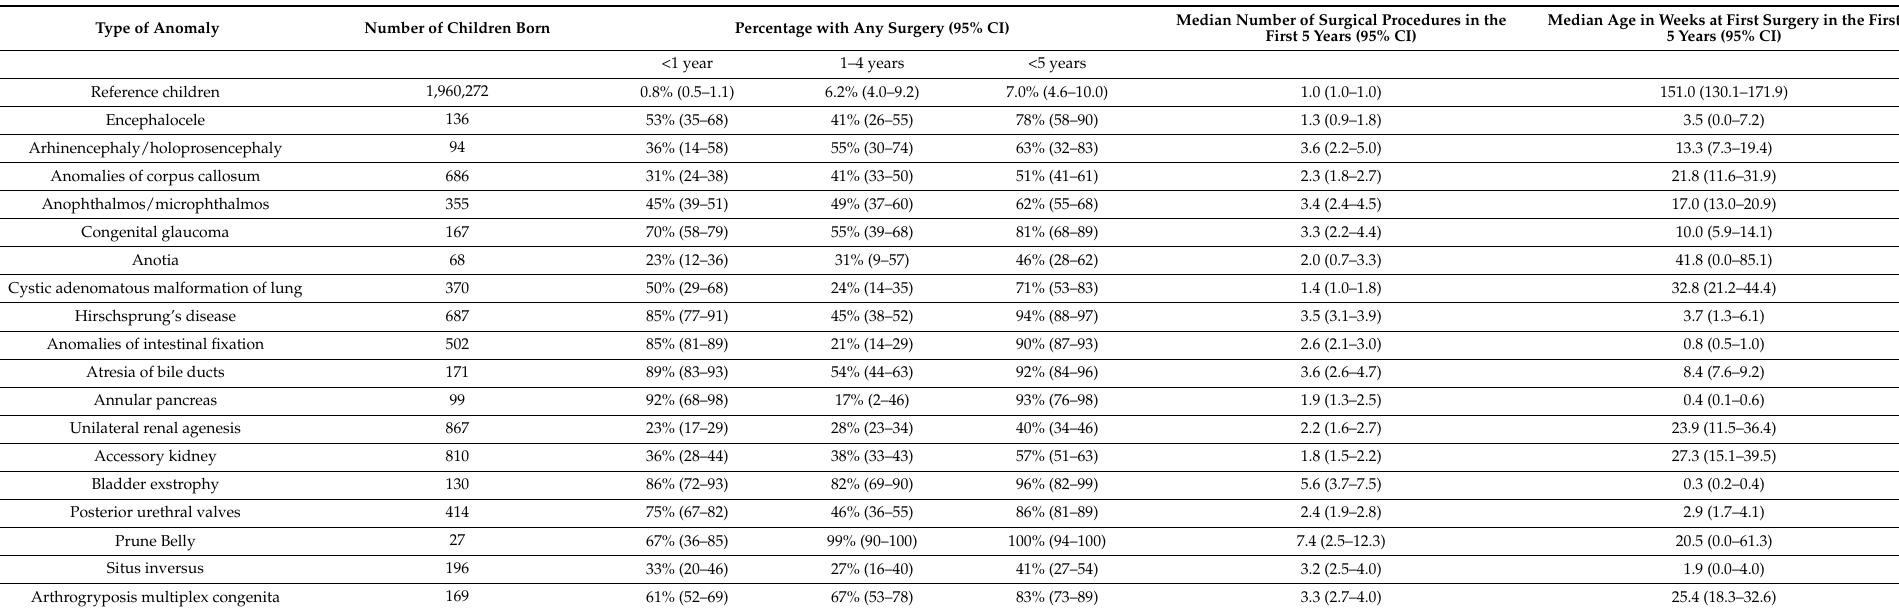
Table 2. The percentage of children with rare congenital anomalies having any surgery by age group, median number of surgical procedures before age 5 years and median age at first